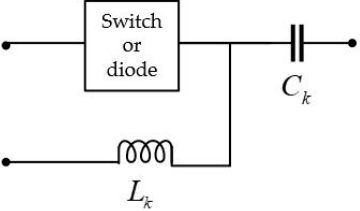
Figure 17. Capacitor–inductor switch/diode tapping equivalent circuit.